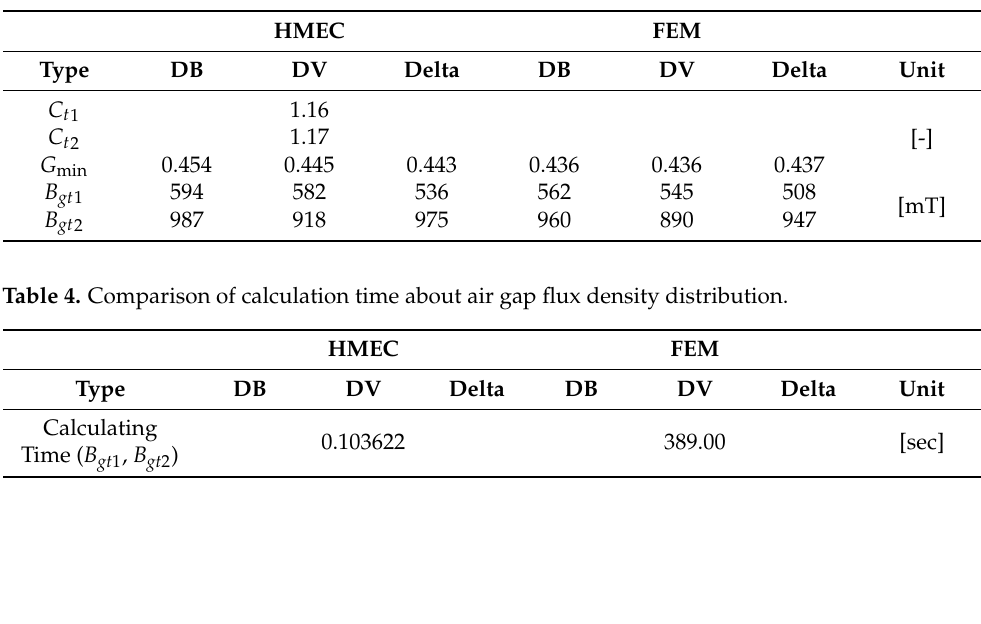
Table 3. Comparison of parameter calculations of the air gap flux density distribution according to double-layer rotor type.